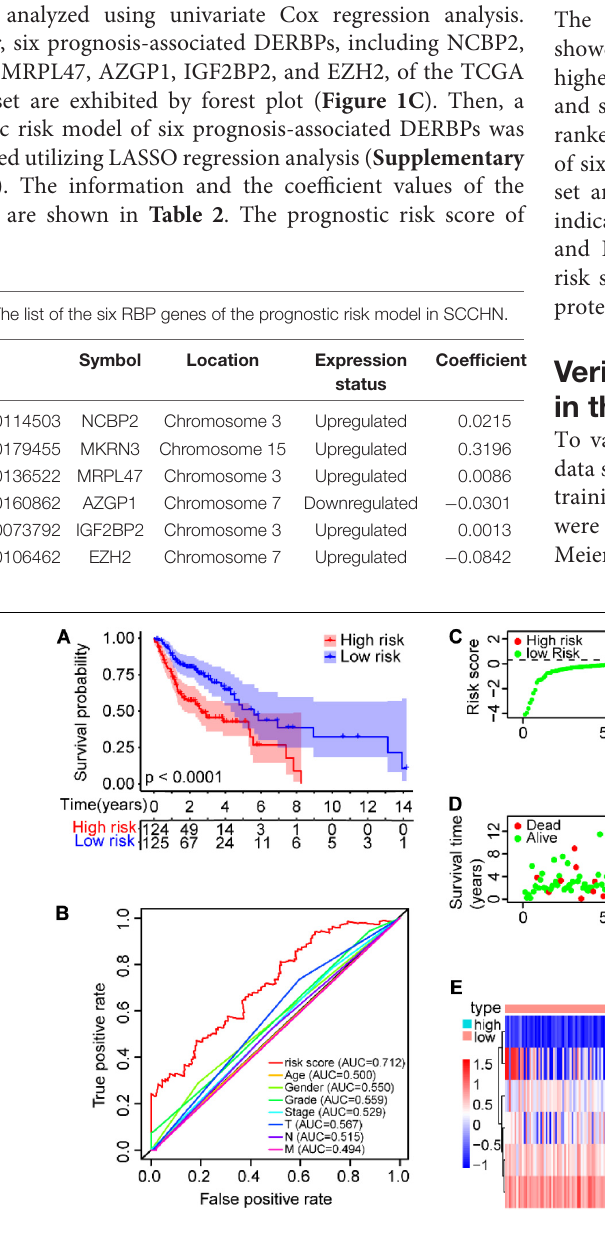
FIGURE 4 | Construction of the prognostic risk model of SCCHN patients in the TCGA training set. (A) Kaplan–Meier survival curve with OS of SCCHN patients in the high-risk and low-risk groups in the TCGA training set. (B) ROC curve demonstrating AUC value of the risk score and other clinical parameters of SCCHN patients. (C) The risk plot distribution of SCCHN patients with high-risk and low-risk scores. (D) The survival status of SCCHN patients. (E) The expression patterns of the six genes of the risk model in TCGA training set.